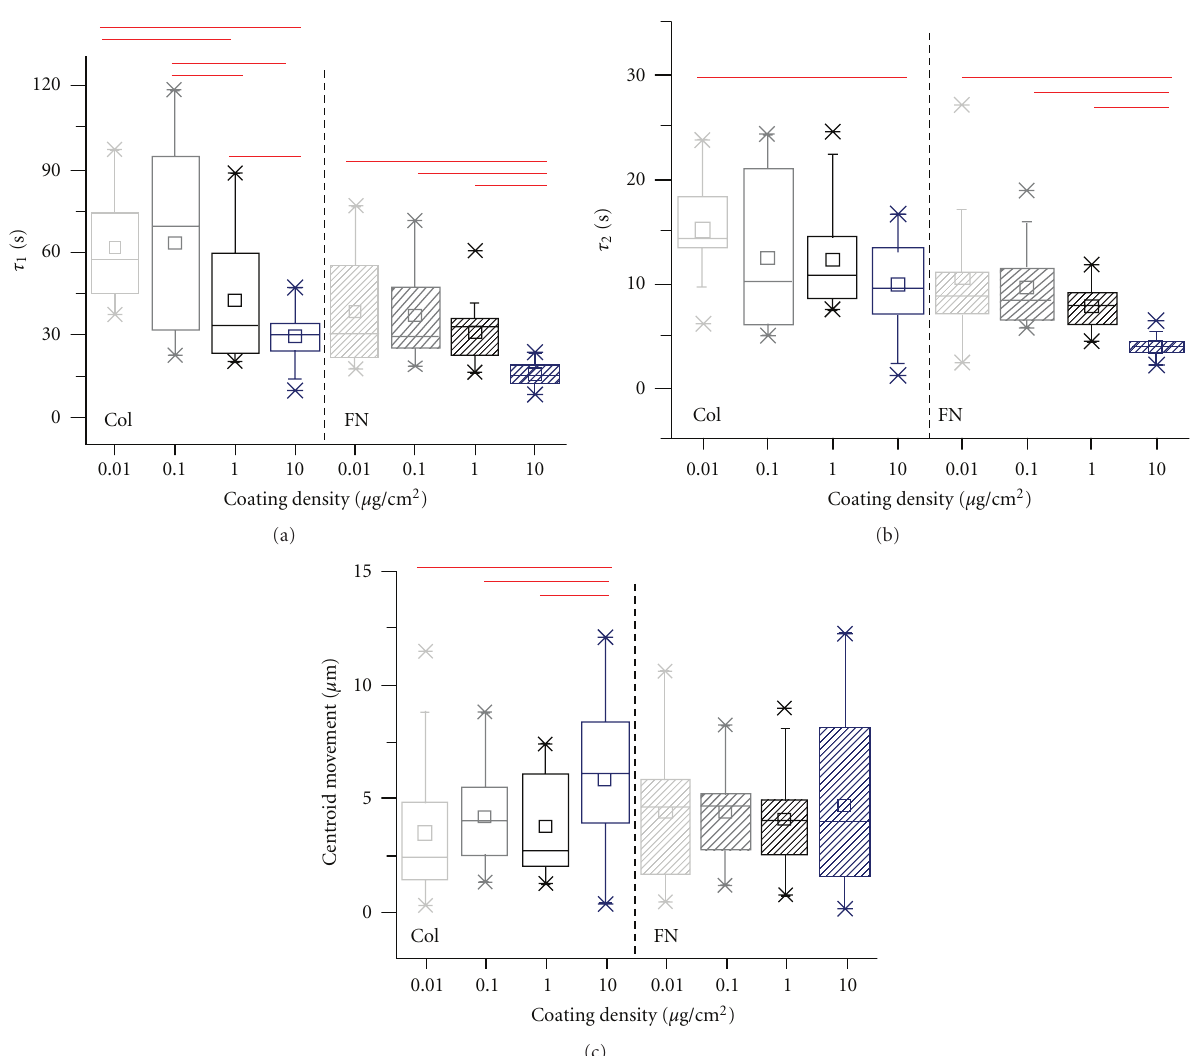
Figure 5: ECM density-dependent deadhesion dynamics of MDA-MB-231 cells on collagen and fibronectin-coated substrates. ((a), (b)) Box whisker plots of time constants of retraction ( τ 1 and τ 2 ) on coverslips coated with collagen and fibronectin at varying densities. Faster deadhesion was observed at higher coating densities for both the ECM proteins. Bars indicate statistical significance ( ∗ P < 0 . 05). (c) The net movement of the cell centroid during the deadhesion process was quantified for individual conditions. Centroid movement remained constant for all the conditions except on the 10 μ g/cm 2 collagen-coated surfaces where it was significantly higher ( ∗ P < 0 .